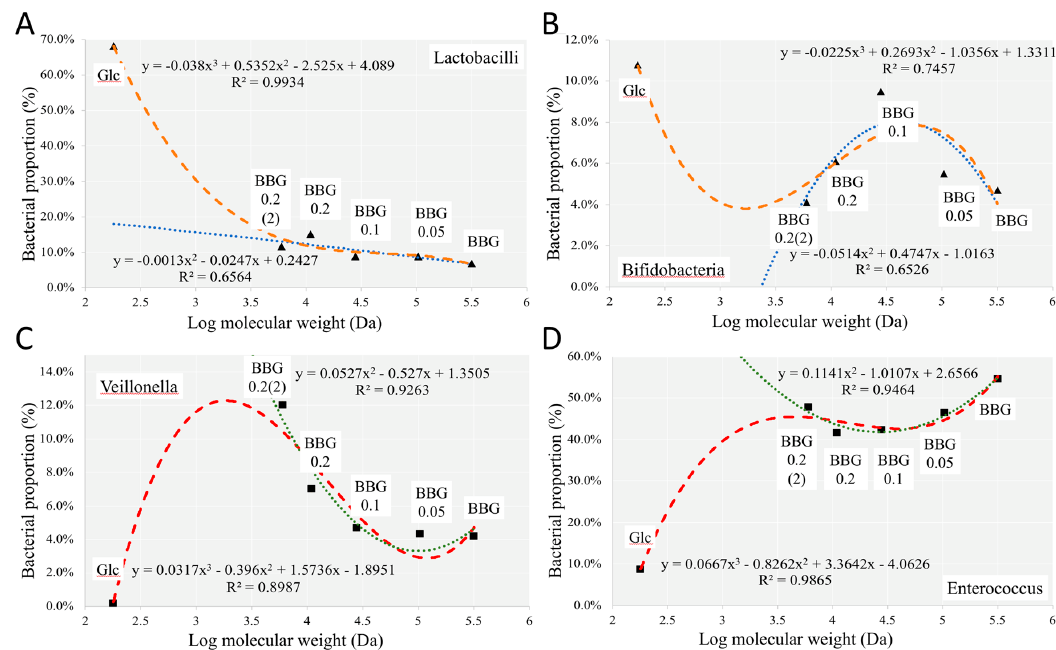
Figure 12. Correlation analysis of selected taxa at genus level against BBGs of different MWs with glucose as monomer. ( A ) Lactobacillus ; ( B ) Bifidobacterium ; ( C ) Veillonella ; and ( D ) Entrococcus .